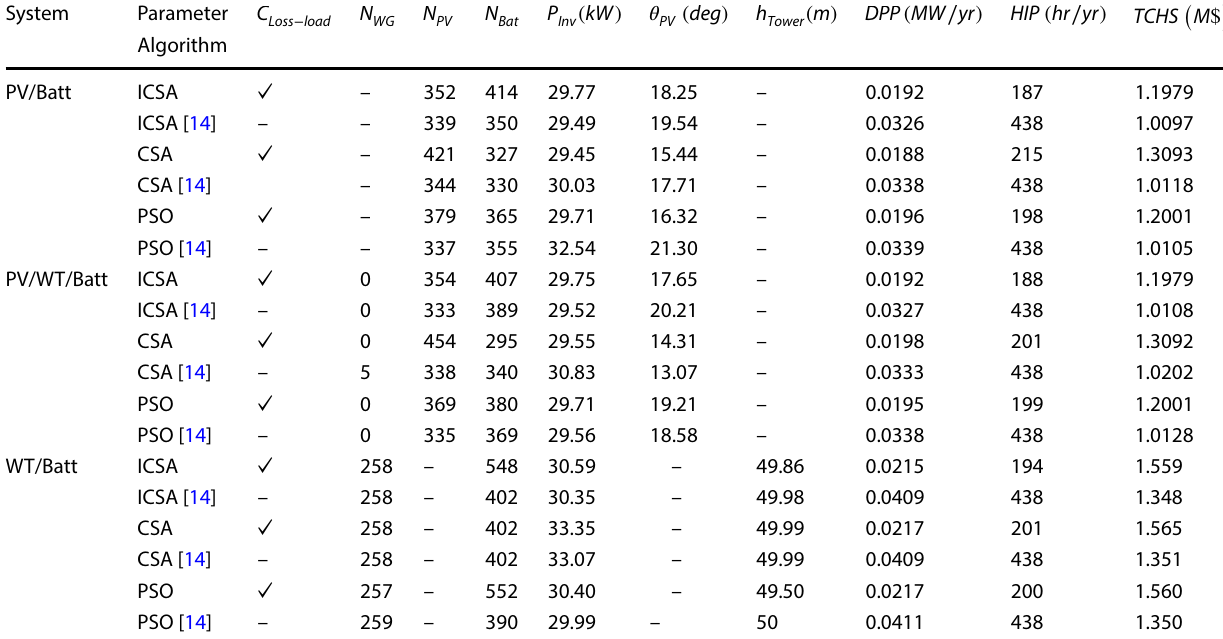
Table 3 The sizing results of different hybrid system combinations for DPHIPmax = 5% with and without C loss − load System